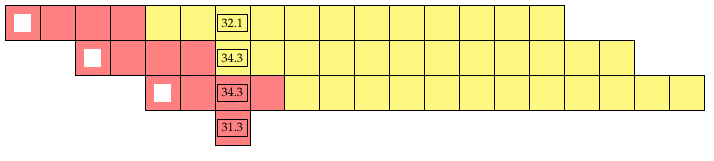
Figure 2. The rolling window